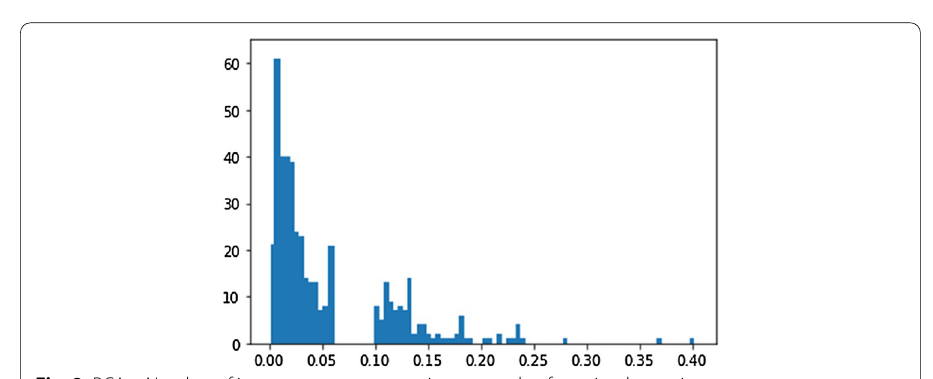
Fig. 8 PCA—Number of instances vs reconstruction error value for noisy data